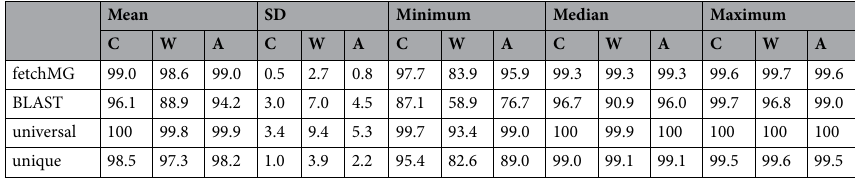
Table 1. Universalism and uniqueness of USCGs. The subcolumns with the name C, W, and A refer to the corresponding percentage for the USCGs from Creevey et al., Wu et al., and Alneberg et al.,